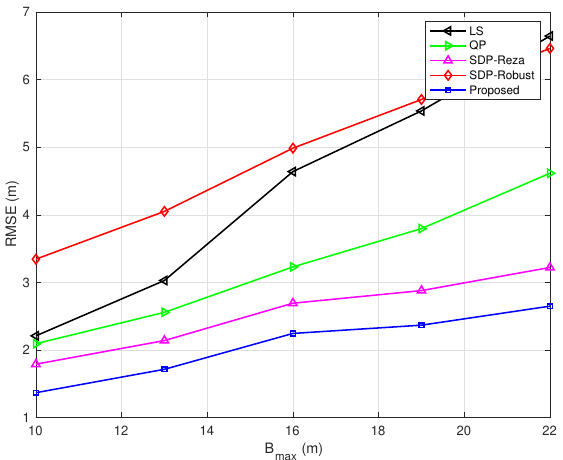
Figure 2. Root mean-square errors (RMSEs) vs. non-line-of-sight (NLOS) error bound B max ( σ = 0.5 m, and the number of NLOS links equals 4 ) .